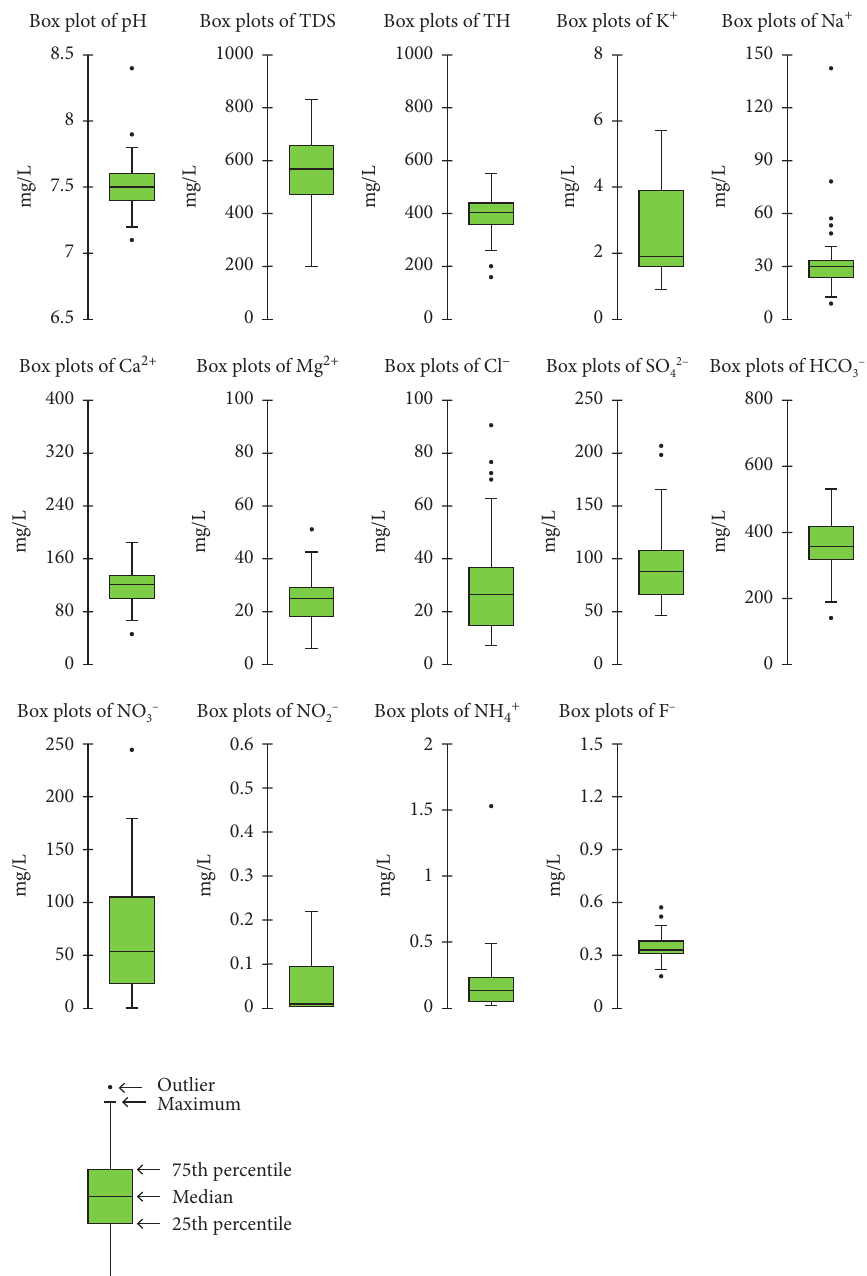
Figure 3: Box and Whisker plot of hydrochemical parameters of groundwater